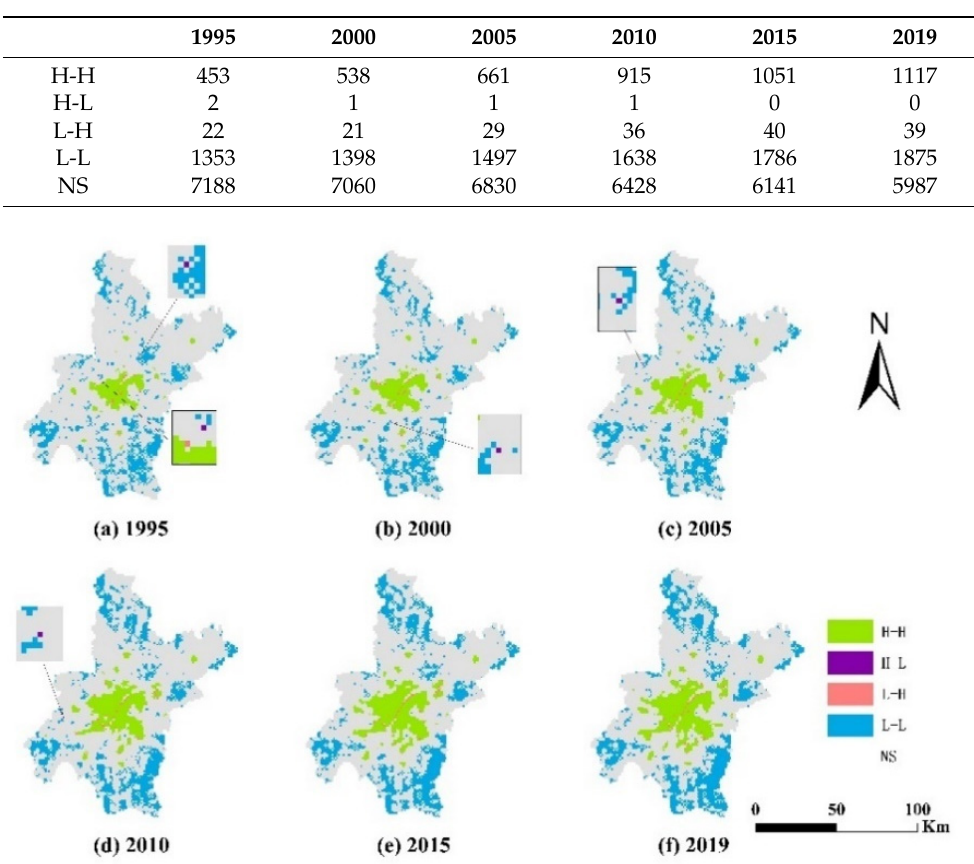
Table 7. Results of spatial local autocorrelation analysis between carbon emissions and UCL area in Wuhan, 1995–2019.